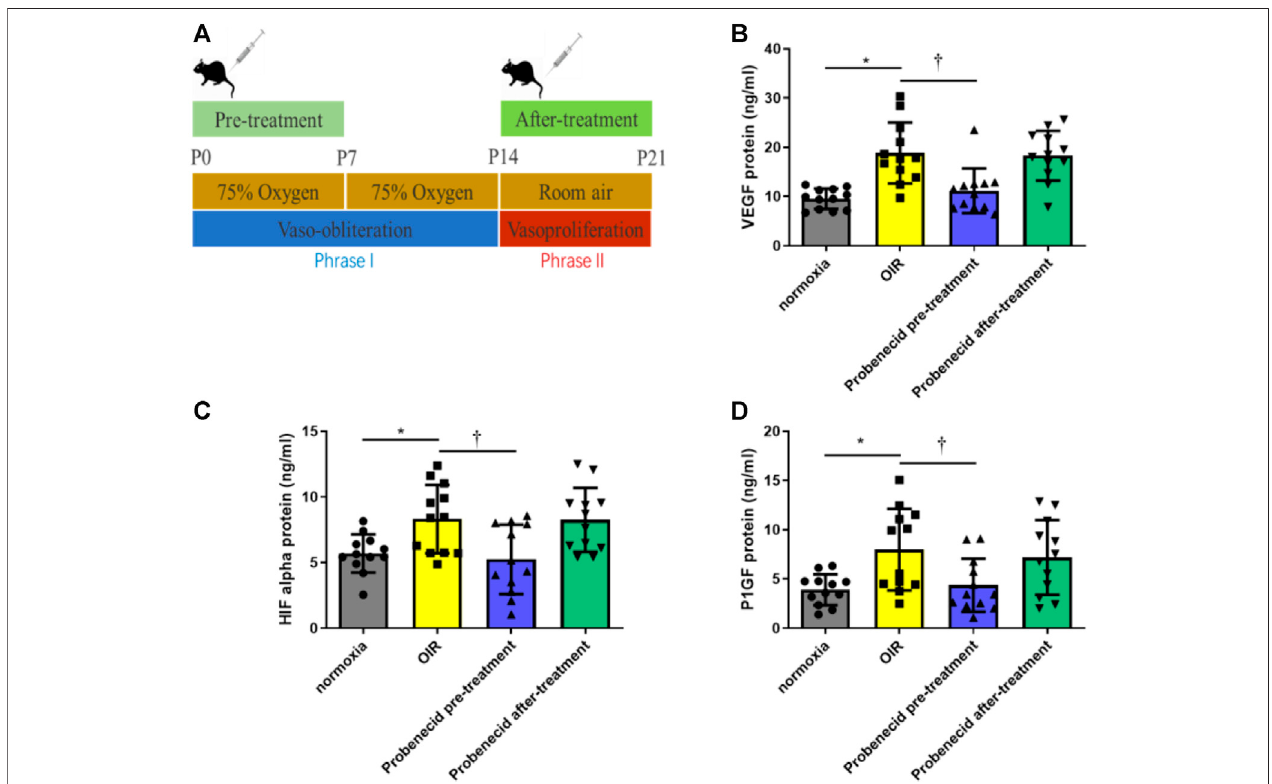
FIGURE2| ProbenecidinhibitsoverproductionofVEGF,HIF-1 α ,andP1GFinducedbyhypoxia. (A) Schemeofoxygen-inducedretinopathy(OIR):SDratpupsare exposedto75%oxygenfromP1toP14toinduceretinalvessellossandarereturnedtoroomairatP15 – P21.ELISAwasusedtoevaluate (B) VEGF, (C) HIF-1 α ,and (D) P1GFlevelsintissuelysates.Bargraphsrepresenttheconcentrationsofeachproteininthefourgroups.Resultsareexpressedasmean ± SD;n (cid:2) 12ratspergroup,* p < 0.05, vs normoxia; † p < 0.05, vs OIR. Signi fi cance was determined by one-way ANOVA with Tukey ’ s post hoc